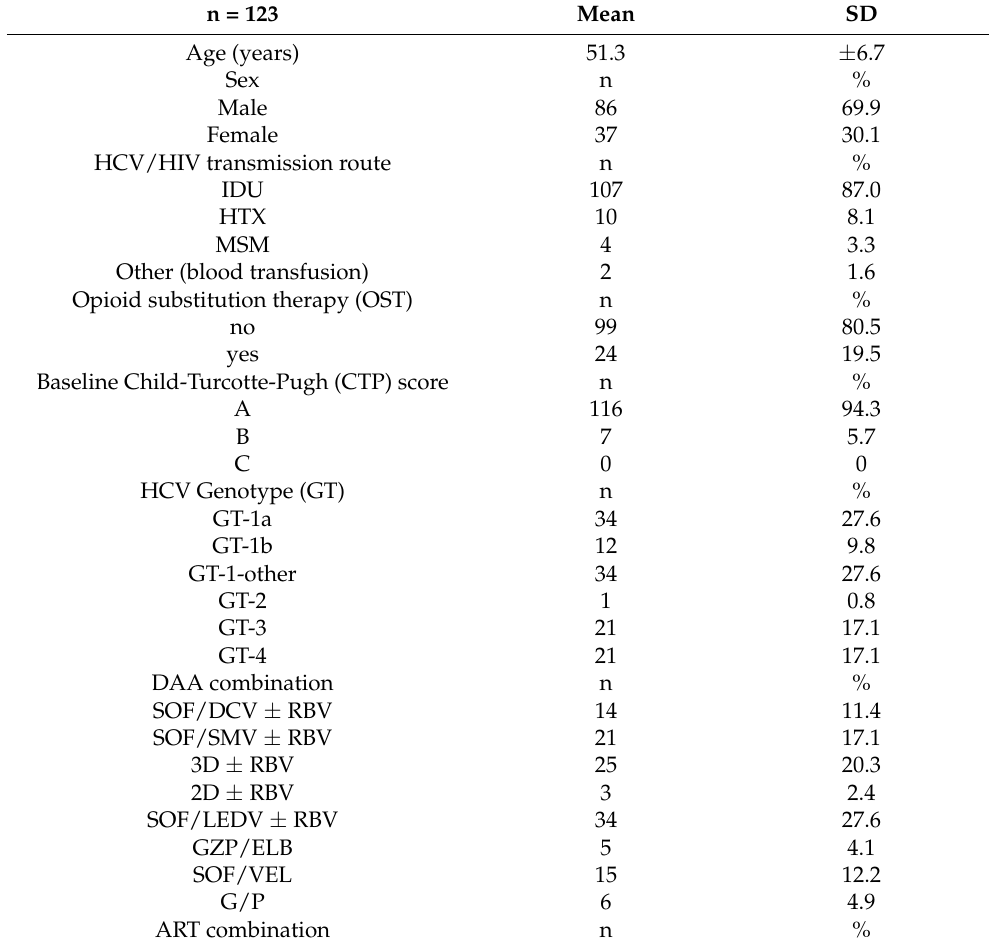
Table 1. Baseline characteristics of SVR12 patients based on age, sex, transmission route, opioid substitution therapy, ART, DAA, and HCV genotype (n = 123) *. n =